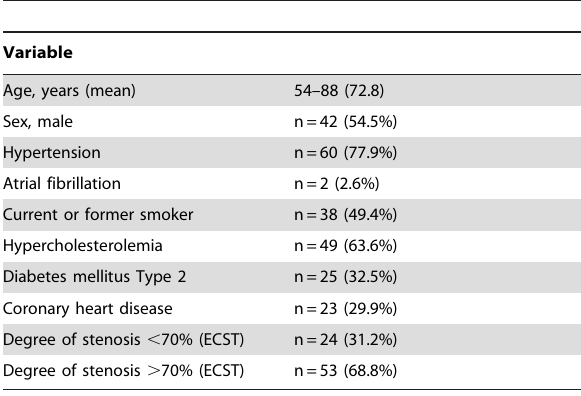
Table 1. Baseline demographic characteristics of